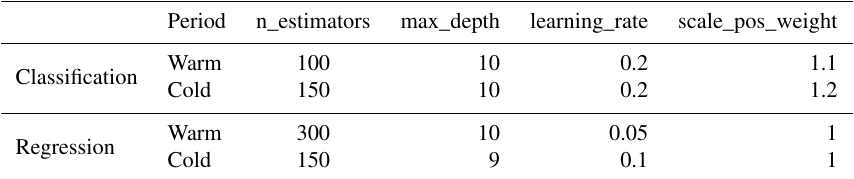
Table C3. The optimal parameters of XGBoost model